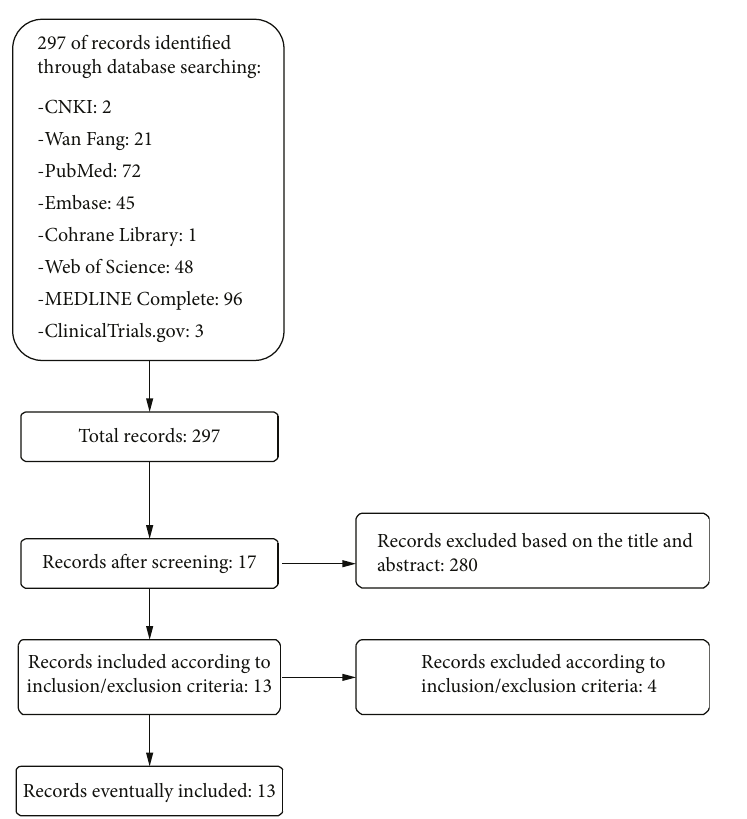
Figure 1: Flow diagram of searching and article